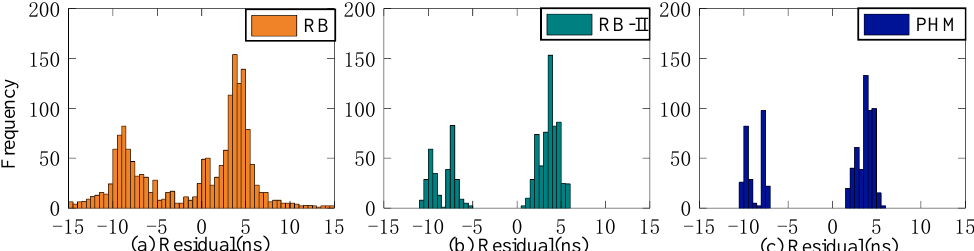
Figure 23. Multiday prediction residual statistics of the ISUP model. ( a ) The residual distribution of the RB clock. ( b ) The residual distribution of the Rb-II clock. ( c ) The residual distribution of the PHM clock.